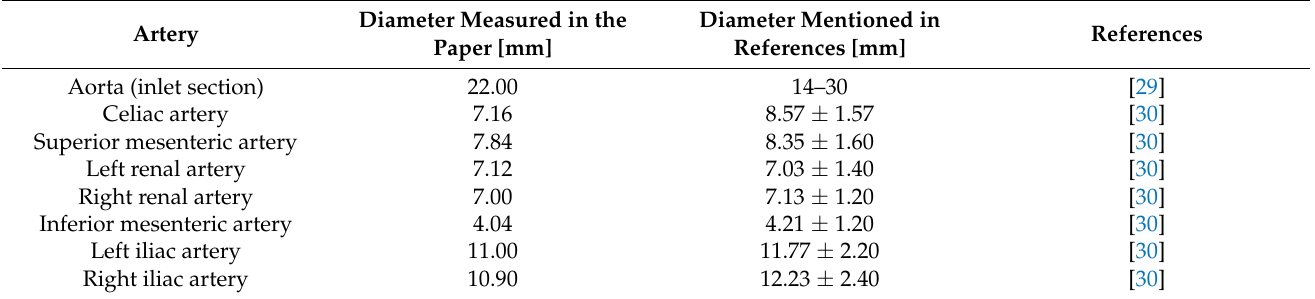
Table 1. Reconstructed arteries’ geometrical